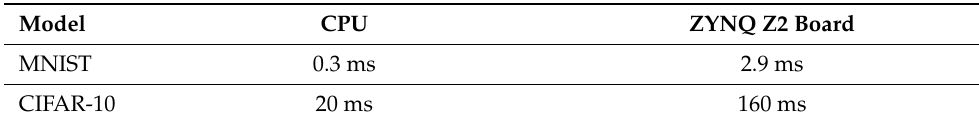
Table 1. Execution time for different platforms and models, integer 8.